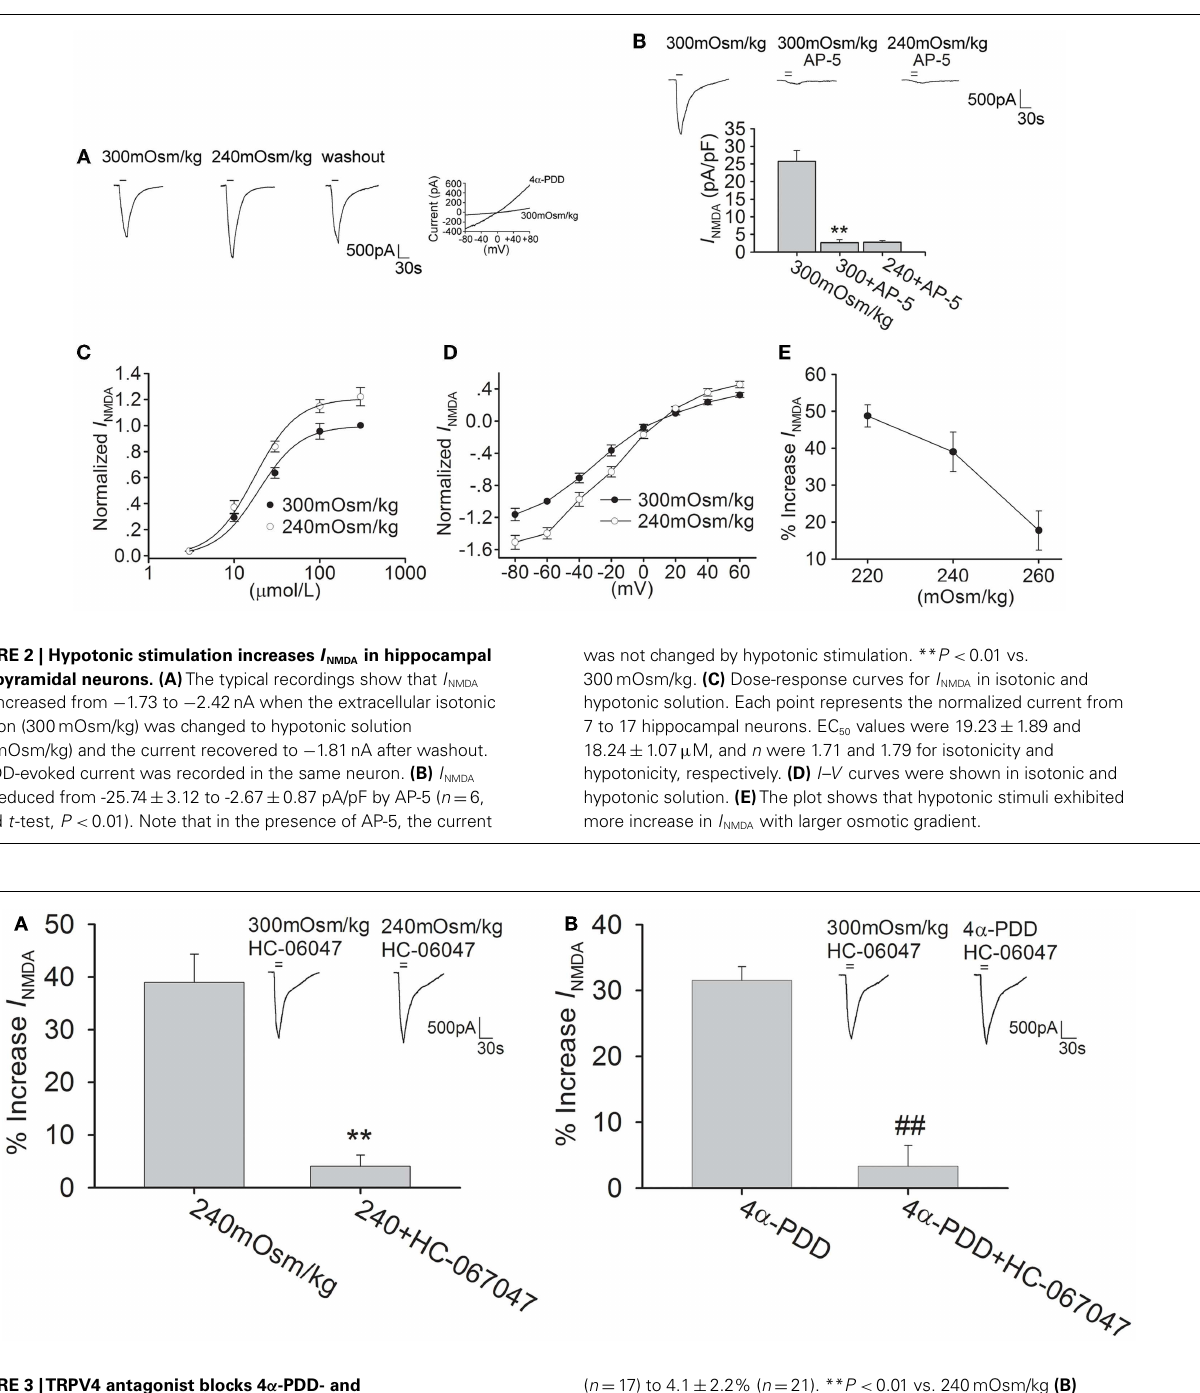
( n = 17) to 4.1 ± 2.2% ( n = 21). ** P < 0.01 vs. 240mOsm/kg (B) Pre-application of HC-067047, the increase in I NMDA by 4 α -PDD was decreased from 31.6 ± 2.1% ( n = 10) to 3.3 ± 3.1% ( n = 18). ## P < 0.01 vs. 4 α -PDD.